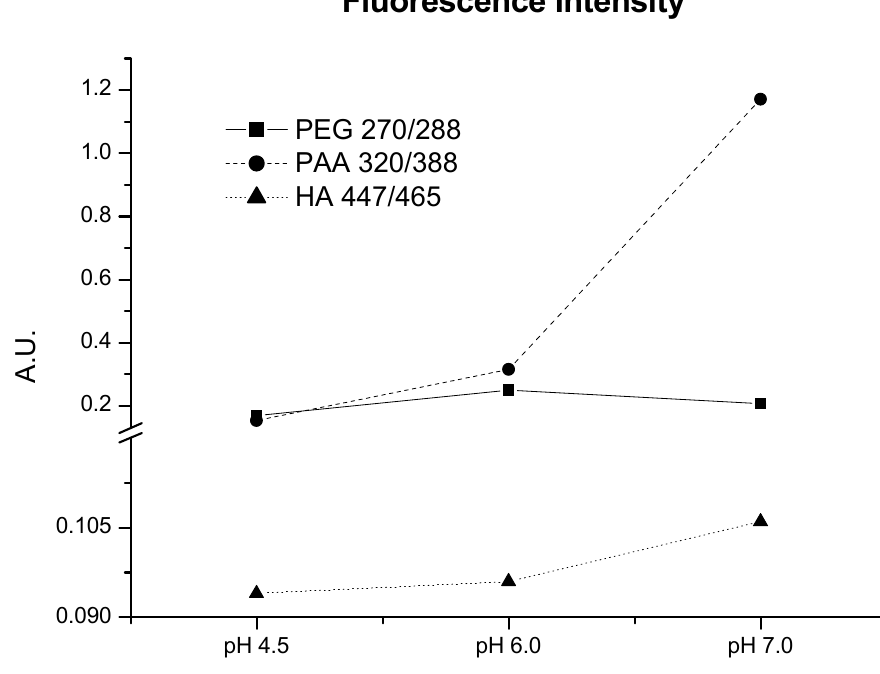
Figure 2. Variations at different pH of the emission/excitation peak fluorescence maximum for PEG, PAA, and HA at work concentration solutions. Intensities expressed in arbitrary units (A.U.). Table 2. Biomarkers content for different treatments